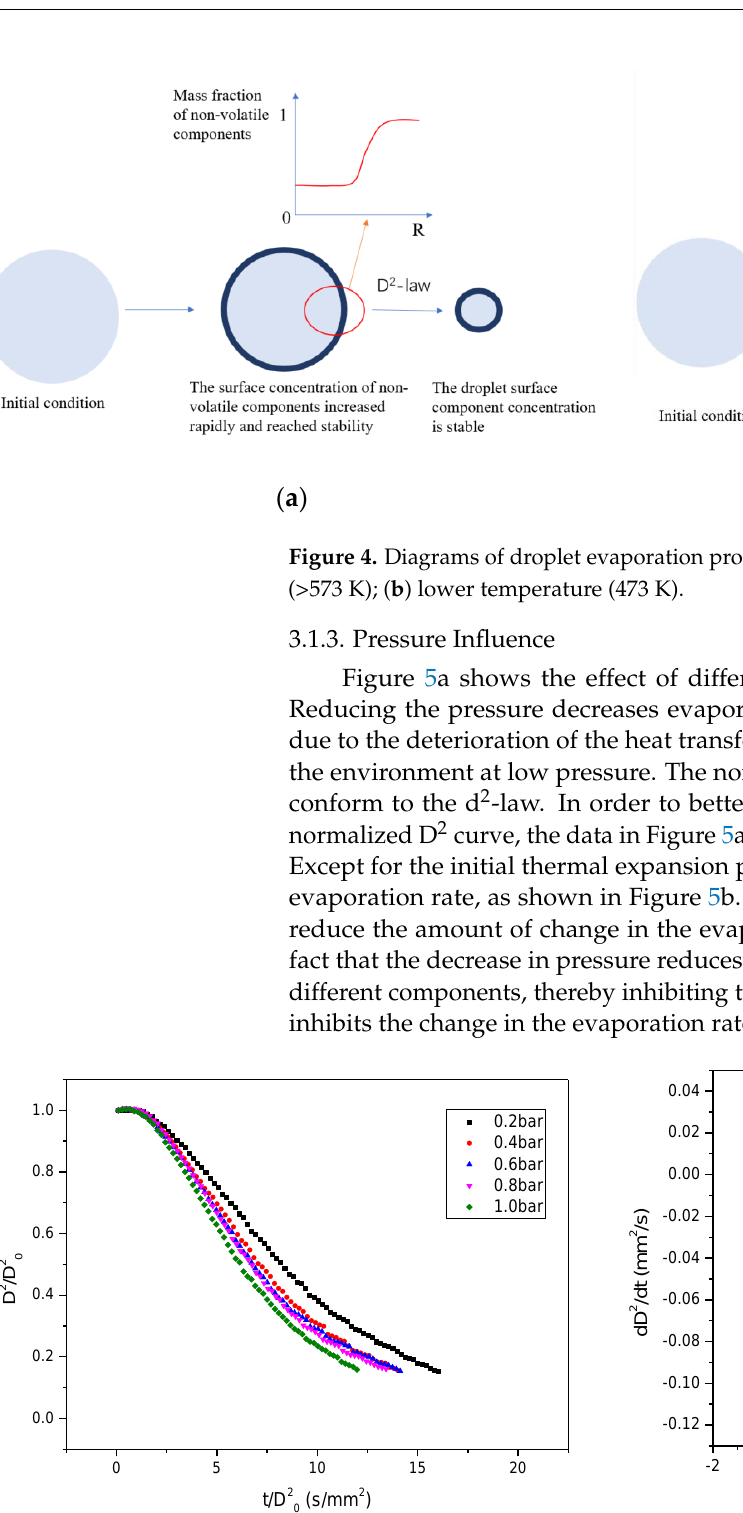
Figure 3. Temporal variation of the normalized D 2 under vary temperatures: ( a ) 1.0 bar; ( b ) 0.4 bar.